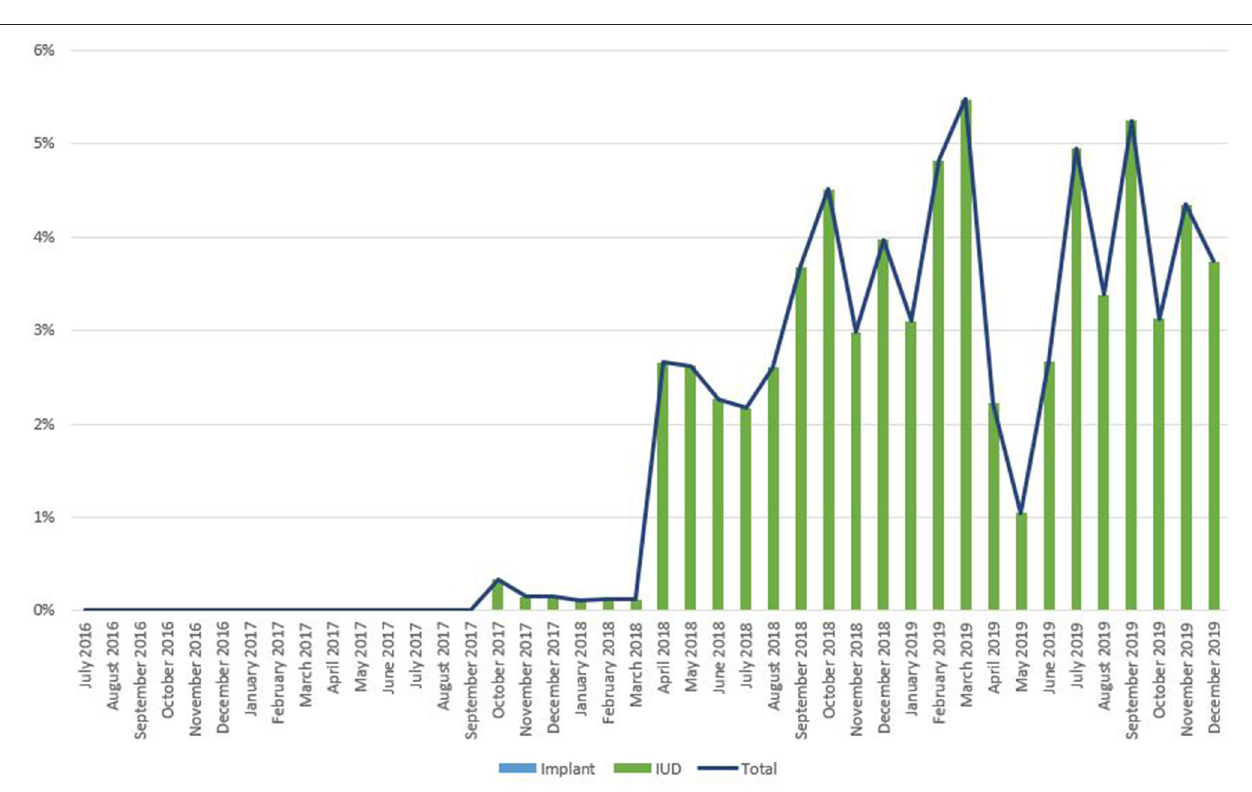
Frontiers in Global Women’s Health |